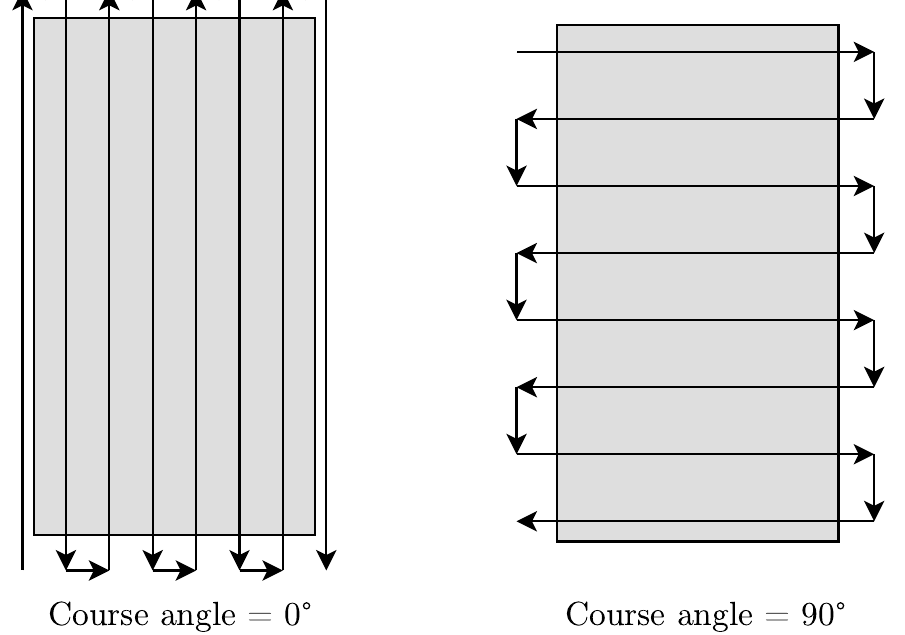
Figure 3. Course angle description (top